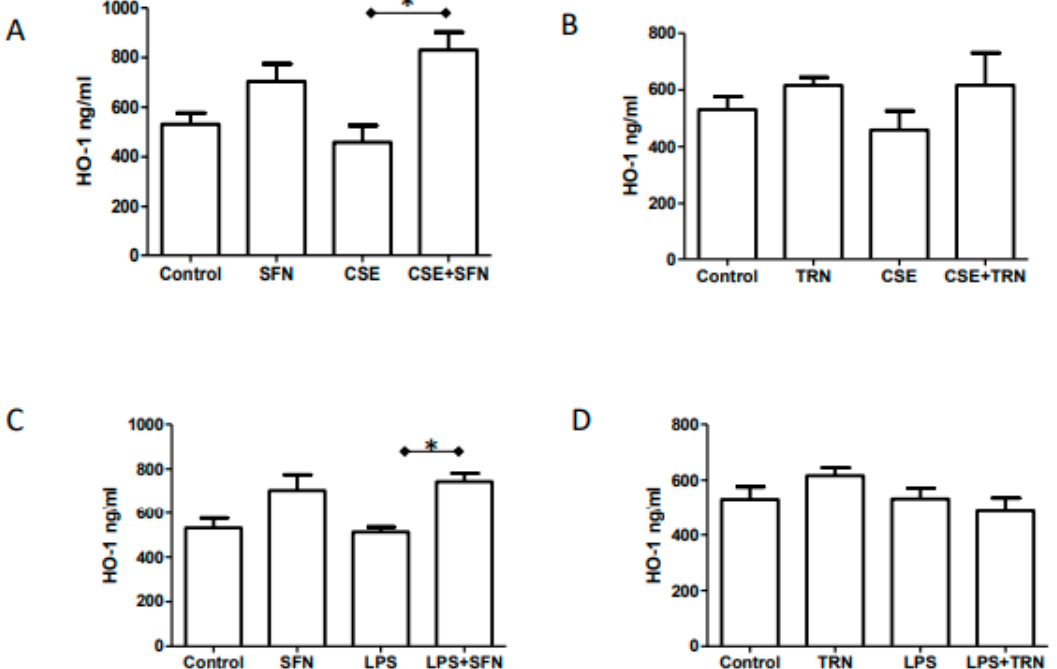
Figure 3. HO-1 levels in fetal membrane tissue homogenates determined by ELISA. * p < 0.05. ( A ): Fetal membranes treated with sulforaphane (SFN), cigarette smoke extract (CSE) and CSE+SFN. ( B ) : Fetal membranes treated with SFN, lipopolysaccharide (LPS) and LPS+SFN. ( C ) : Fetal membranes treated with trigonelline (TRN), CSE and CSE+TRN. ( D ) . Fetal membranes treated with TRN, LPS and LPS+TRN.